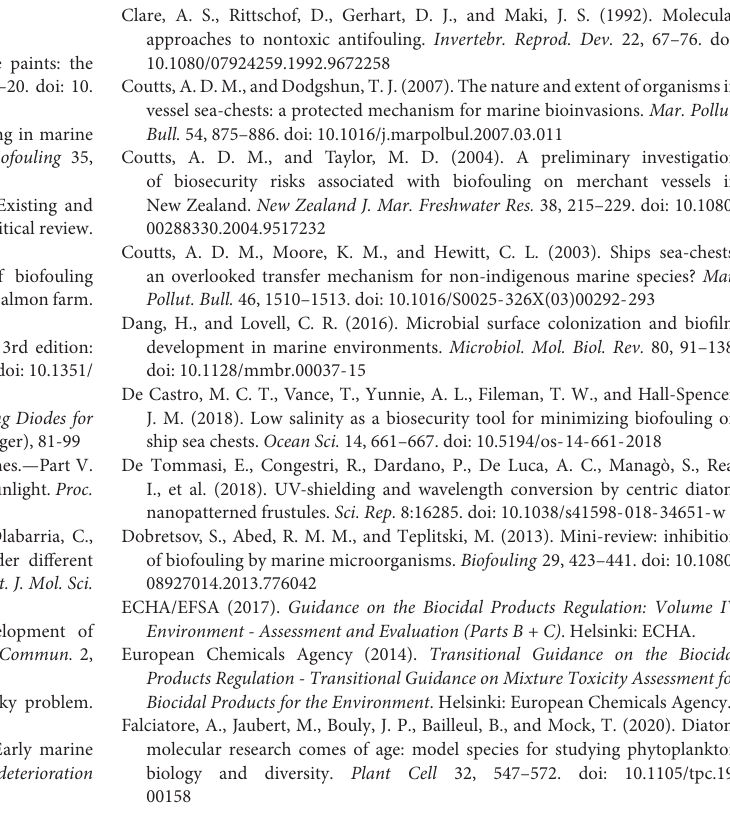
Supplementary Table 1 | Experimental exposures, cell densities, and percentage